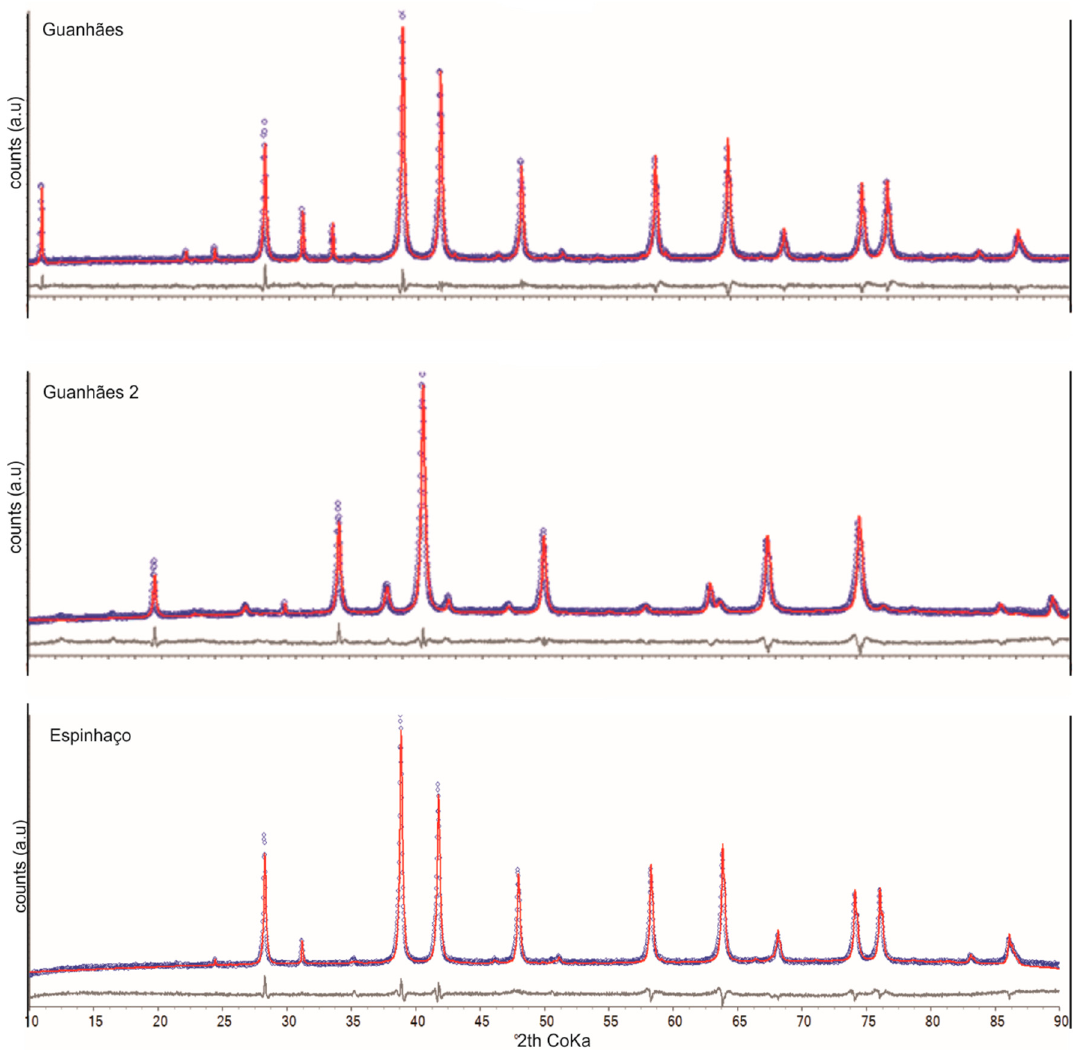
Figure 1. Rietveld method refinement results for the iron ore samples from Quadrilátero Ferrífero. Measured and calculated patterns as blue circles and red line, respectively, residue as the respective gray line at the bottom.